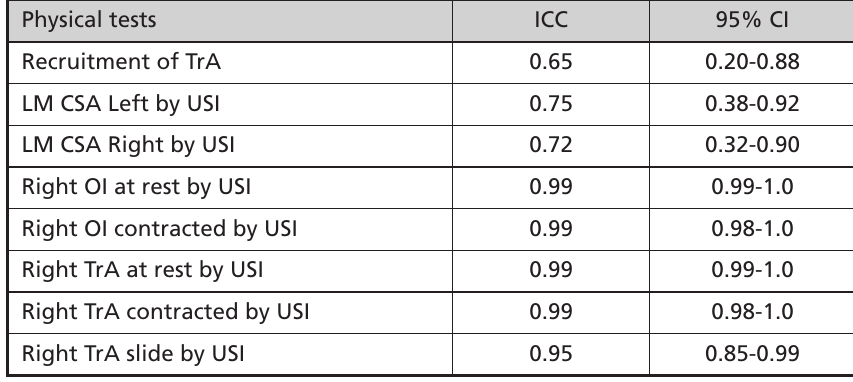
Table 2: Cumulative Hours Exposure at Time of Testing Students